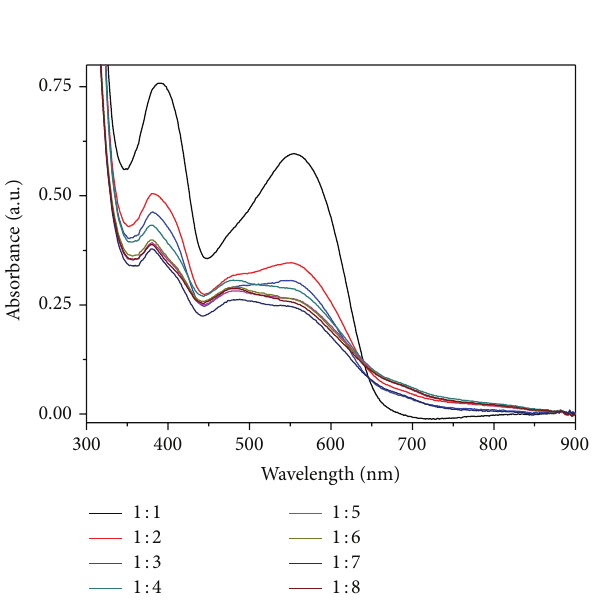
Figure 6: UV-visible absorption spectra for the active layer with different ratio of PCDTBT and PC 71